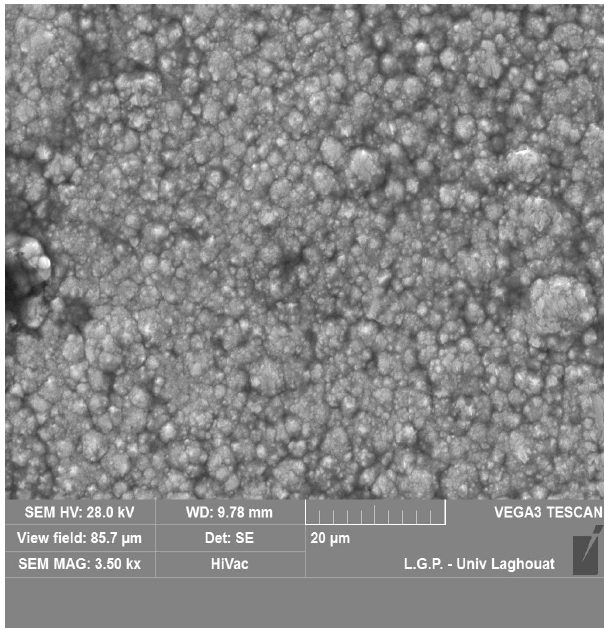
Figure 5. Surface SEM image of the electrodeposited nickel film.